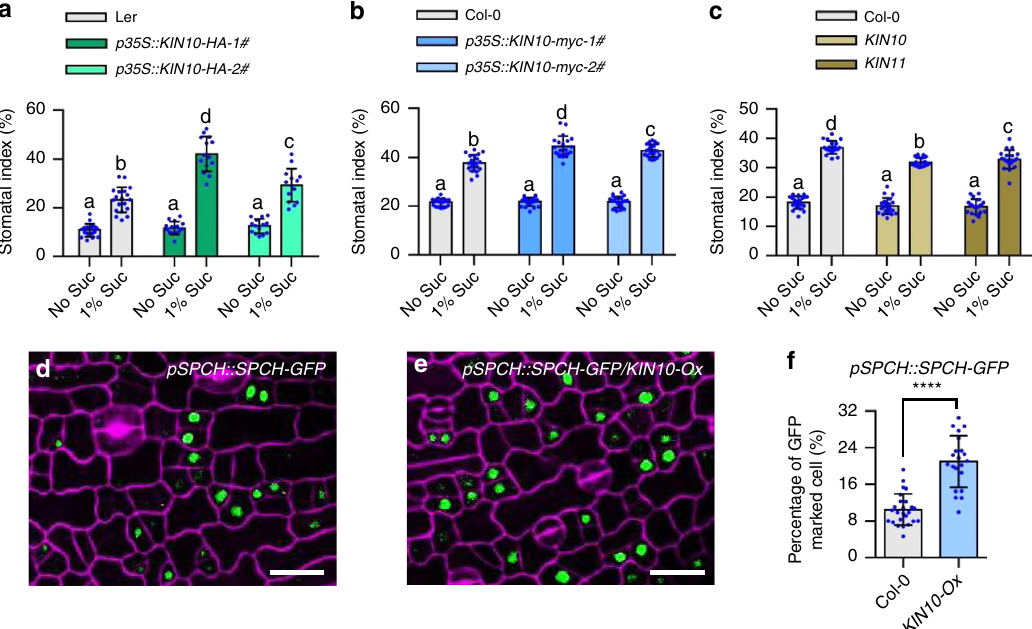
Fig. 2 KIN10 plays crucial roles in sugar-induced stomatal development. a – c Quanti fi cation of the stomatal index of wild-type plants, KIN10-Ox and kin10 mutants. Seedlings of wild-type plants (Ler and Col-0), p35S::KIN10-HA (Ler background), p35S::KIN10-myc (Col-0 background), kin10 mutant and kin11 were grown in ½ MS liquid medium with or without 1% sucrose for 10 days under long-day condition. Error bars indicate standard deviation (S.D.) ( n = 15 – 20). Different letters above the bars indicated statistically signi fi cant differences between the samples (ANOVA analysis followed by Uncorrected Fisher ’ s LSD multiple comparisons test, p <0.05). d – f Overexpression of KIN10 increased the percentage of SPCH-YFP labeled cells to total epidermal cells. Seedlings of pSPCH::SPCH-GFP and pSPCH::SPCH-GFP/KIN10-Ox (p35S::KIN10-myc-2#) were grown in ½ MS liquid medium with 1% sucrose concentration conditions for 3 days under 16h light/8h dark photoperiod. SPCH-GFP is in green, PI-marked cell outlines are in purple. Scale bars in confocal images represent 20 μ m. Error bars indicate S.D. ( n = 20). Asterisk between bars indicated statistically signi fi cant differences between the samples (Student t test, **** p